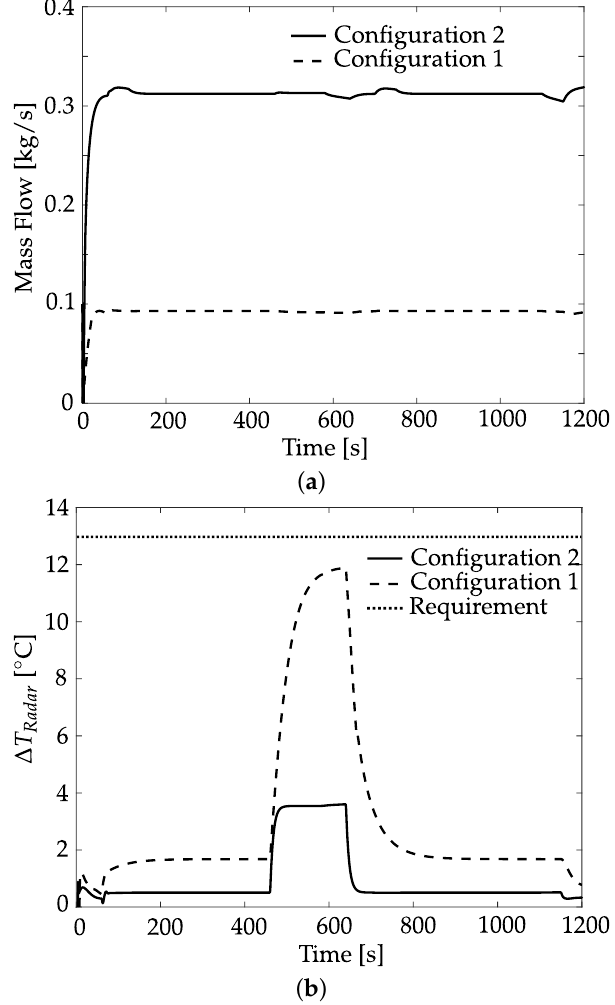
Figure 8. Compilation of simulation result relevant during use-case requirement verification. The re- sults stem from simulations of the two different configurations. Configuration 1 is depicted as dashed, and Configuration 2 as solid; ( a ) coolant distribution system mass flow during the two OpsCon simulations; ( b ) temperature increase over the radar during the two OpsCon